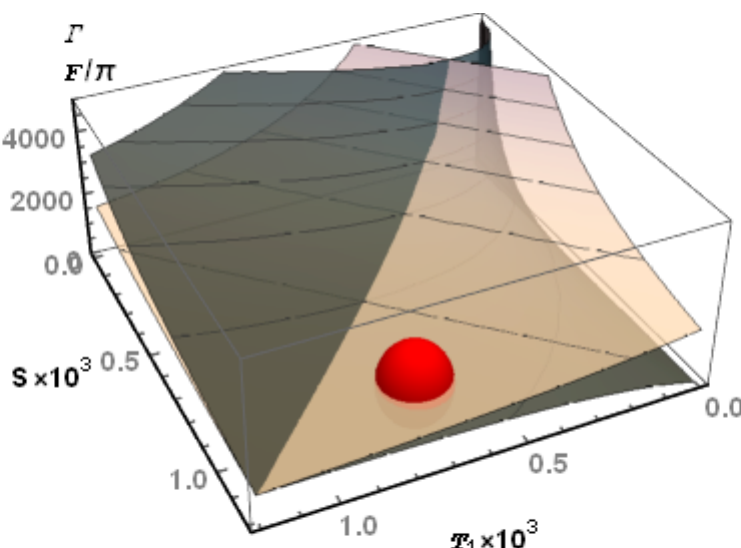
Figure 2. Two-dimensional chart of the finesse F (light) and amplification factor Γ (dark), as functions of the input mirror transmission T 1 and other intracavity losses S , assuming that the intracavity reflection factor of the input mirror is just equal to 1 − T 1 (no other losses). The finesse has been divided by π to make it conspicuous that T 1 = S is the place where Γ = F / π . When S happens to be much smaller than T 1 , the Γ / F ratio can go up to 2 / π . However, in every section of constant S , the maximum value of Γ is found on the T 1 = S diagonal, with a Γ / F ratio of only 1 / π . The ellipse shows the working point for the present